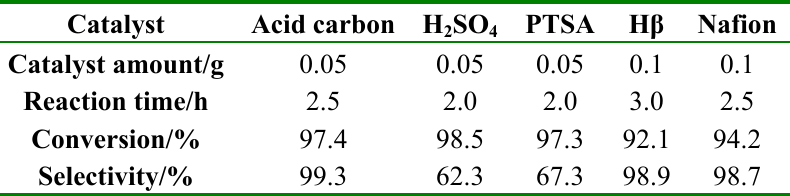
Table 6. Comparison of different